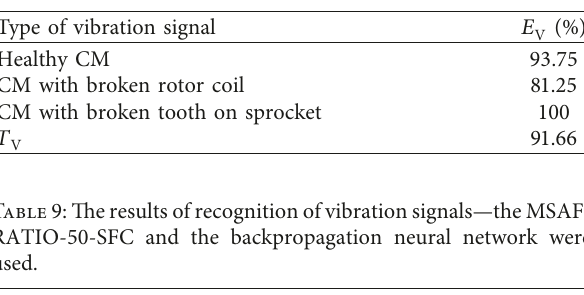
Table 6: The results of recognition of vibration signals—the MSAF- RATIO-50-SFC and the LDA classifier were used.